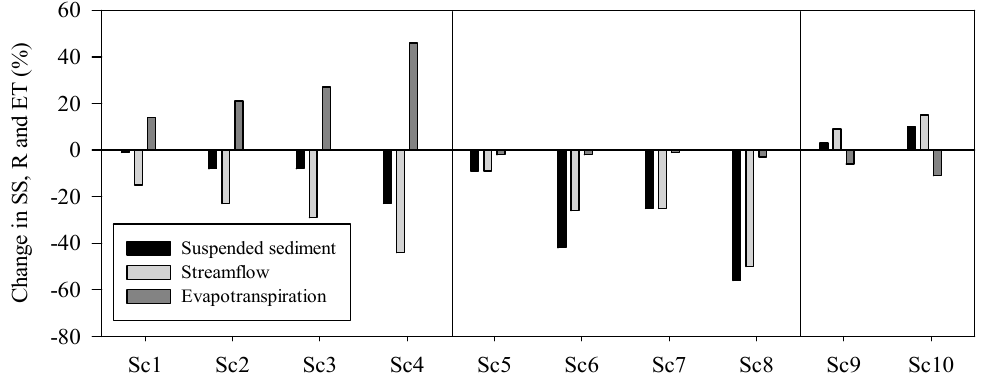
Figure 3. Response of suspended sediment yield (SS), streamflow (R) and evapotranspiration (ET) to changes in temperature (Sc1, Sc2, Sc3 and Sc4), rainfall (Sc5, Sc6, Sc7 and Sc8) and CO 2 concentration (Sc9, Sc10) based on the scenarios defined in Table 1. Sc1: T + mean 2031–2060 °C; Sc2: T + max 2031–2060 °C; Sc3: T + mean 2069–2098 °C; Sc4: T + max 2069–2098 °C; Sc5: P–mean 2031%–2060%; Sc6: P–max 2031%–2060%; Sc7: P–mean 2069%–2098%; Sc8: P–max 2069%–2098%; Sc9: 1.5 × CO 2 ; Sc10: 2 × CO 2 .